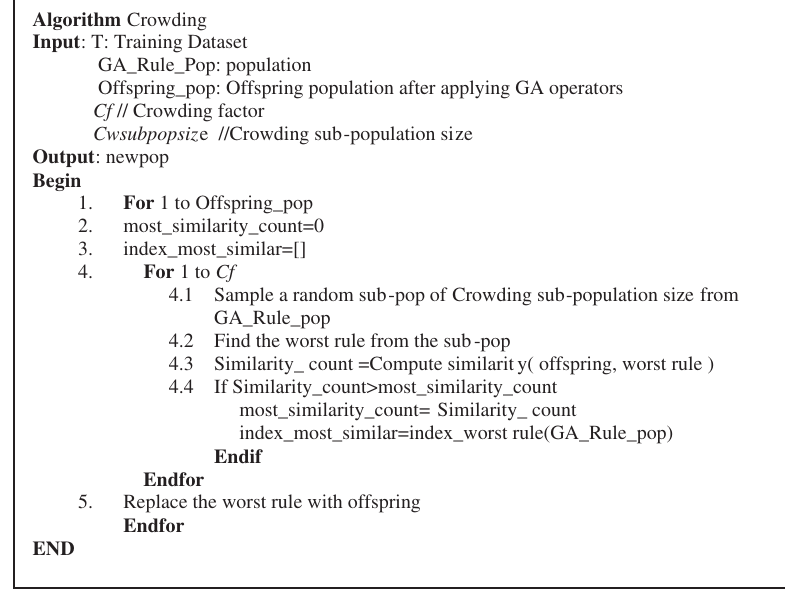
Figure 5: Crowding Algorithm.